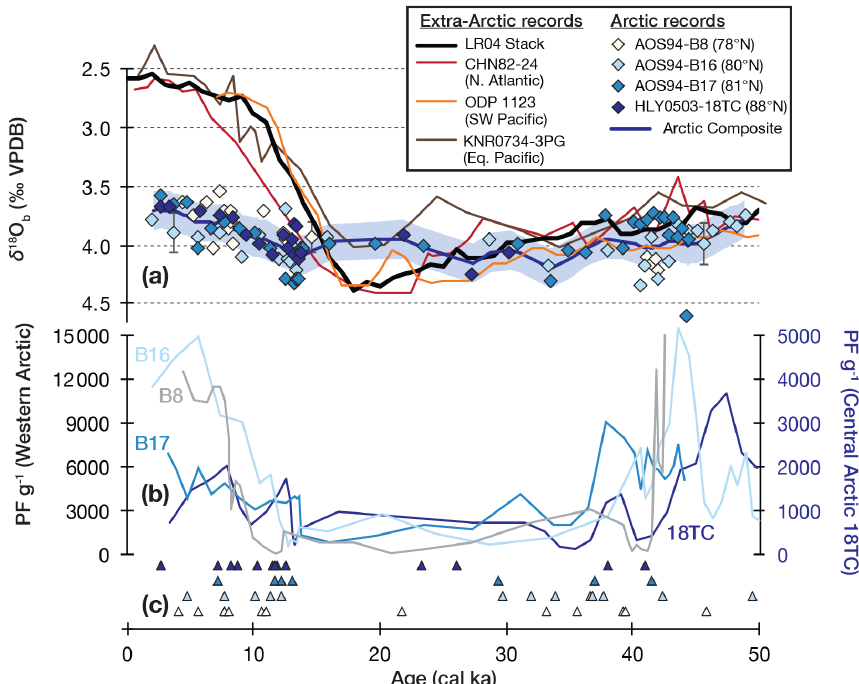
Figure 2. Chronological constraints on Arctic Ocean sediments over the last 50kyr and comparison of Arctic δ 18 O b to δ 18 O b from selected deep ocean sites. (a) δ 18 O b data. White, light blue, medium blue, and dark blue diamonds indicate δ 18 O b data points from AOS94-B8, AOS94-B16, AOS94-B17, and HLY-0503-18tc, respectively. Blue line indicates smoothed spline fit (created in MATLAB using the smooth- ing parameter p = 0 . 5); shading indicates ± 1 RMSE for spline smoothing function. Other δ 18 O b records shown are the LR04 global stack (black line; Lisiecki and Raymo, 2005), CHN-82-24-4PC (red line; Boyle and Keigwin, 1985), ODP 1123 (orange line; Elderfield et al., 2010), and KNR0734-3PG (brown line; Curry et al., 1988); all records are shown as C. wuellerstorfi -equivalent δ 18 O b values. (b) Abun- dance of planktonic foraminifera per gram of sediment for western Arctic sites B8 (gray), B16 (light blue), and B17 (medium blue) (left axis) and the central Arctic Site HLY0503-18TC (dark blue, right axis). (c) Radiocarbon dates on planktonic foraminifera; colors the same as in panel (a)